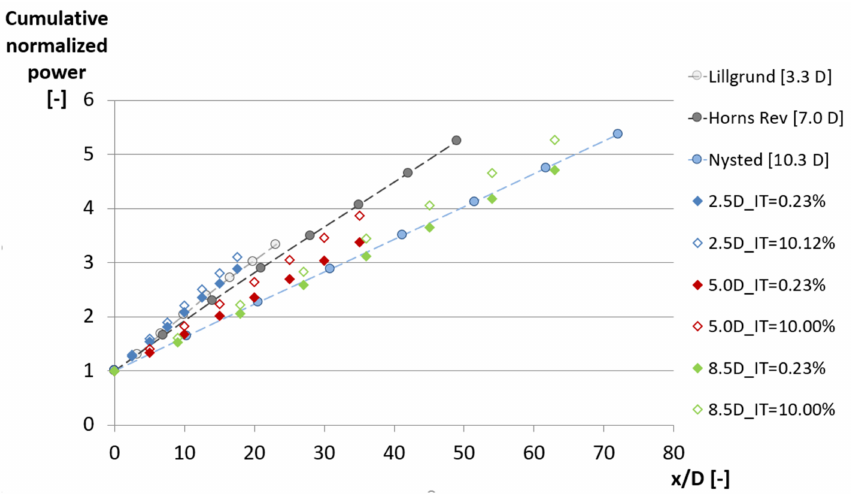
Figure 16. Comparison of cumulative power of eight full-scale turbines in Nysted [49], Lillgrund and Horns Rev [50] wind farms compared with current results